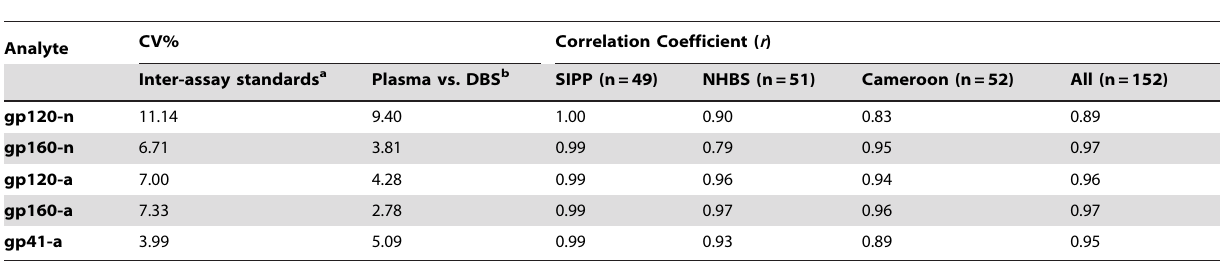
Table 2. Correlation in antibody reactivity between plasma and DBS.